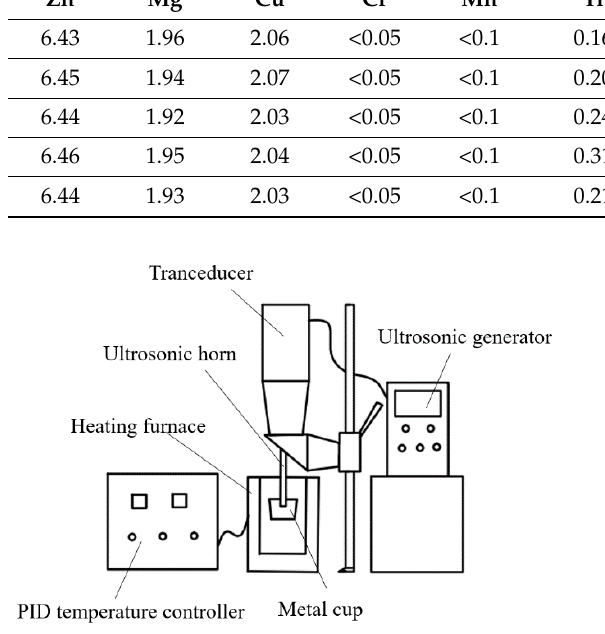
Table 1. Compositions of the alloy samples (in wt.%) and casting processes. Zn